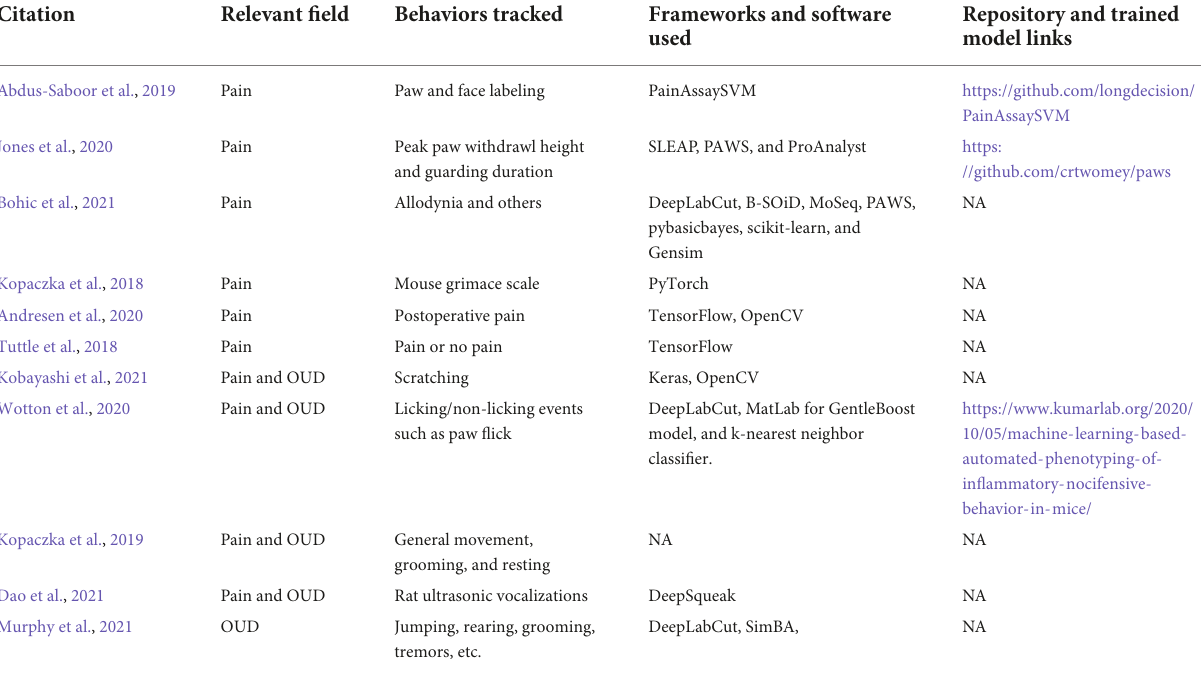
TABLE 1 Summary of automated pain and opioid use disorder (OUD) behavioral analysis